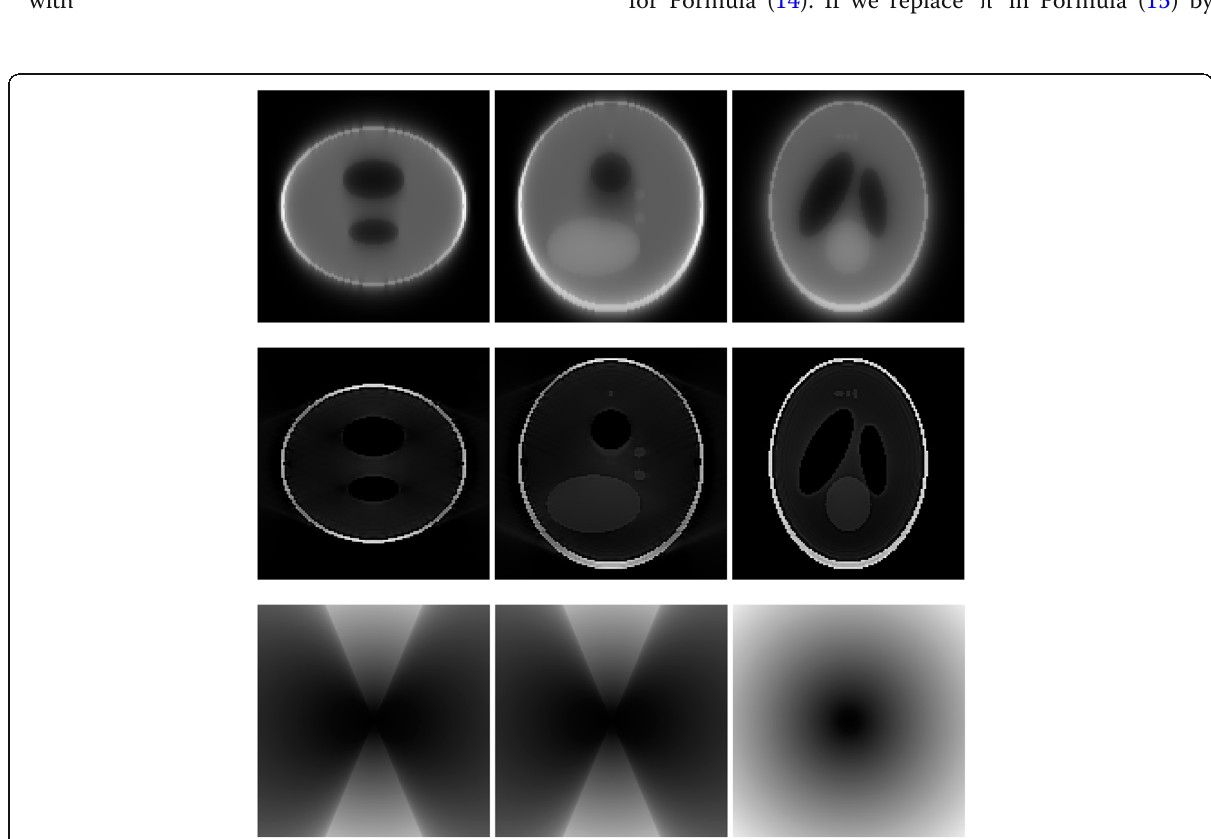
Fig. 4 Image reconstruction using proposed algorithm for the case of ψ = π /8 and σ = 10. Row 1 : TOF backprojection. Row 2 : Final reconstruction. Row 3 : Tomographic filter H . Three central orthogonal cuts are shown for each